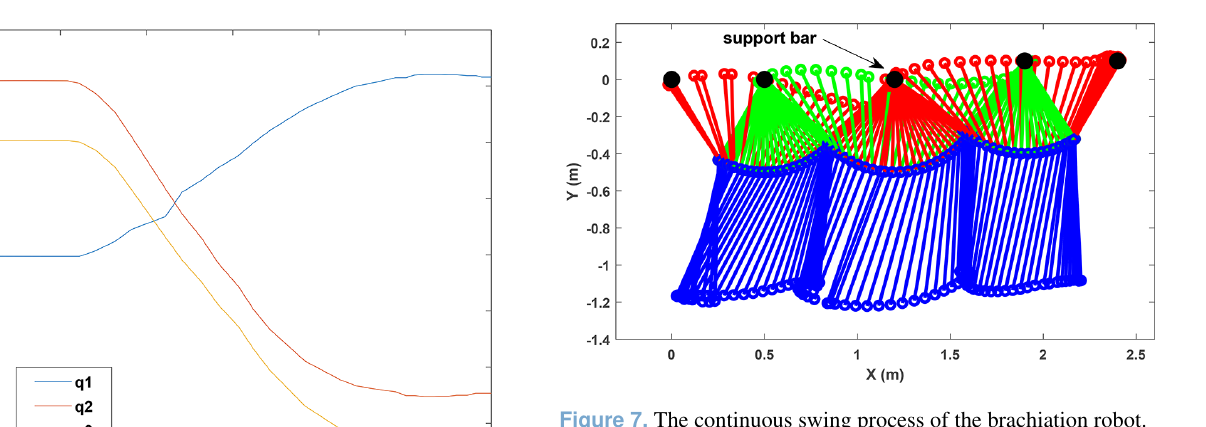
Figure 7. The continuous swing process of the brachiation robot.